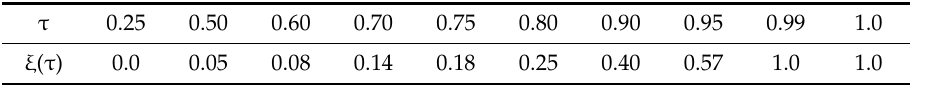
Table 2. Distribution summary of the response variable (the incident rate of children’s BLL ≥ 5 µg/dL). τ 0.25 ( ) τξ